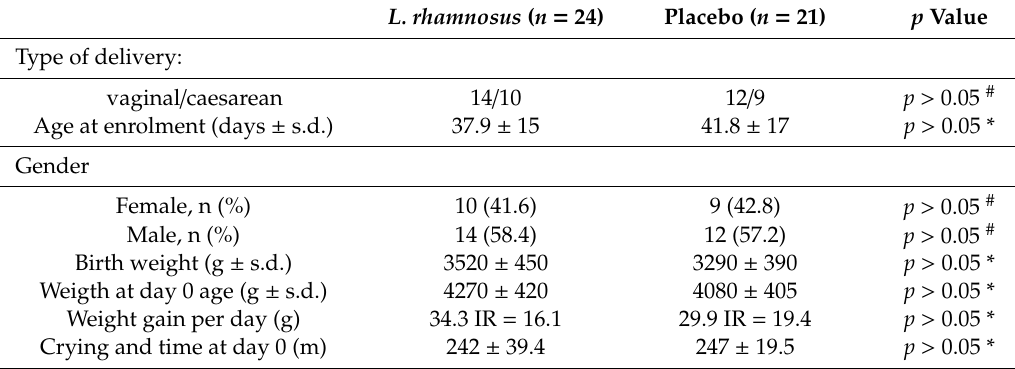
Table 1. Characteristics of the two study groups of infants involved in the study: Lactobacillus rhamnosus (ATCC 53103) and